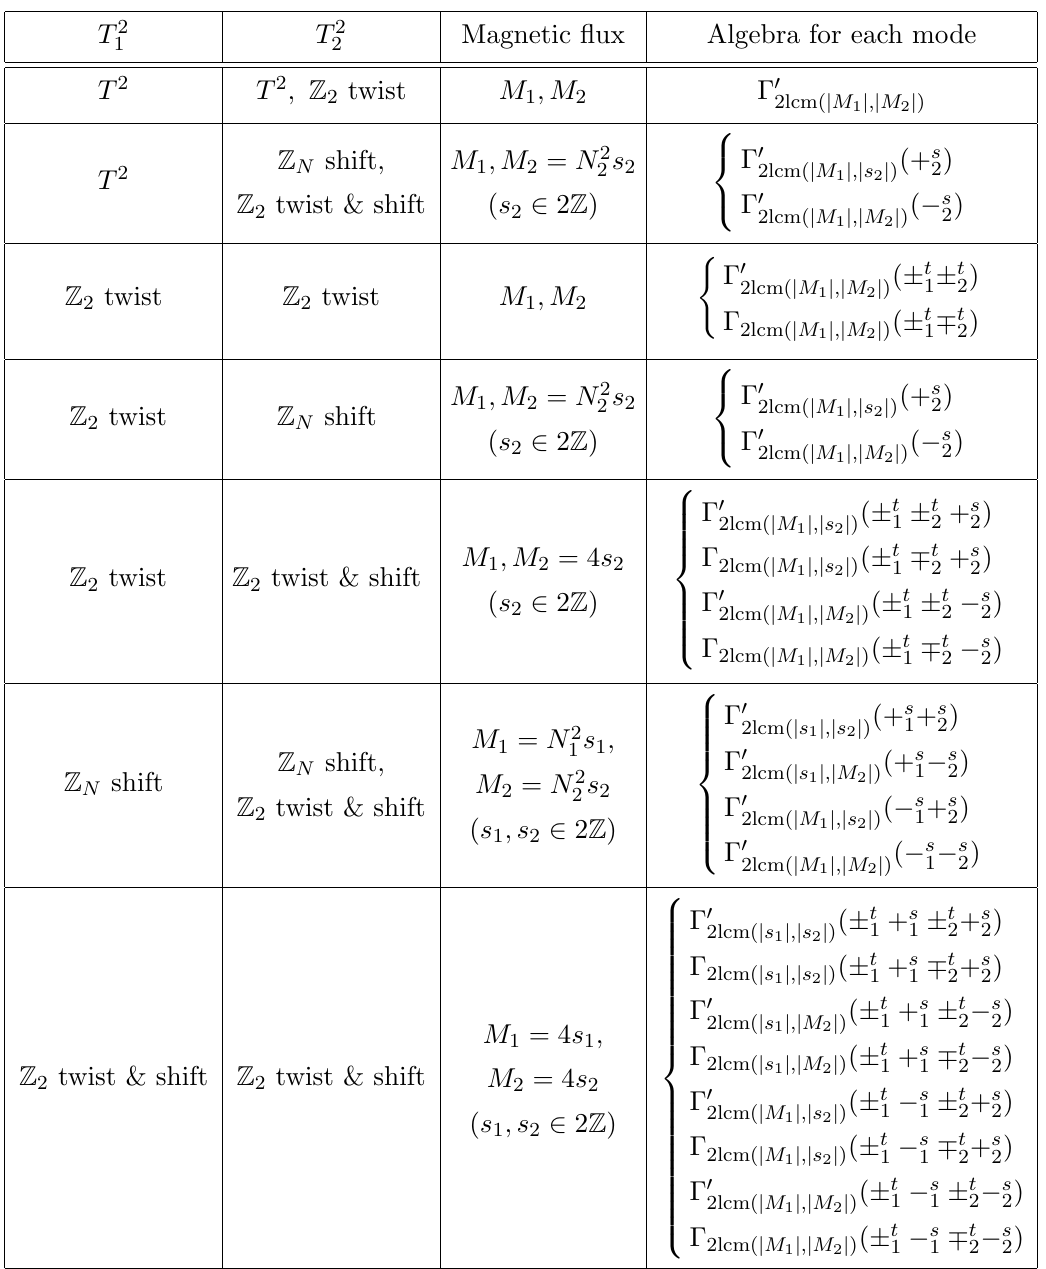
(cid:2) T 2 ) = Z N twist and 1 2 ( T 2 ), which also 1 2